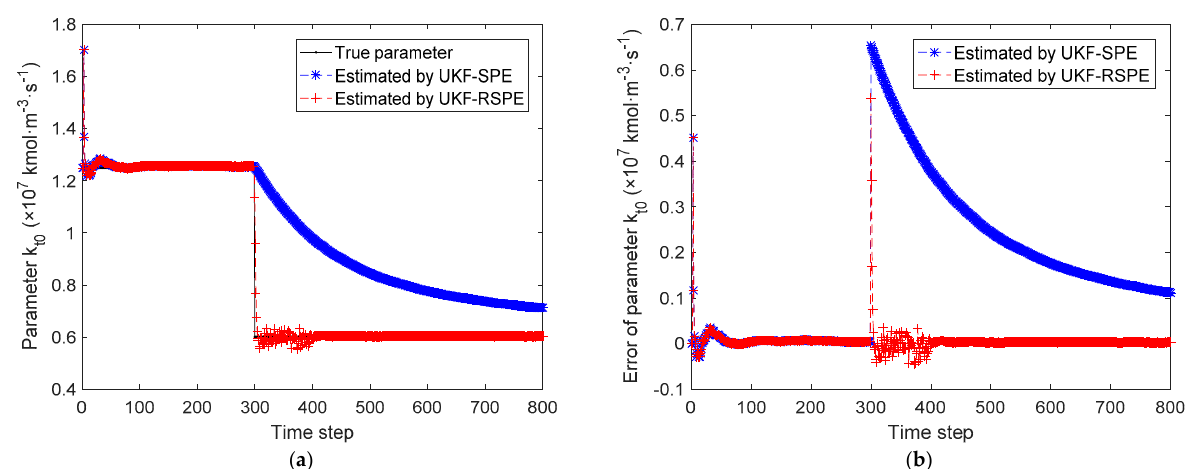
k in Case Study 2.2: ( a ) esti- ,0 t